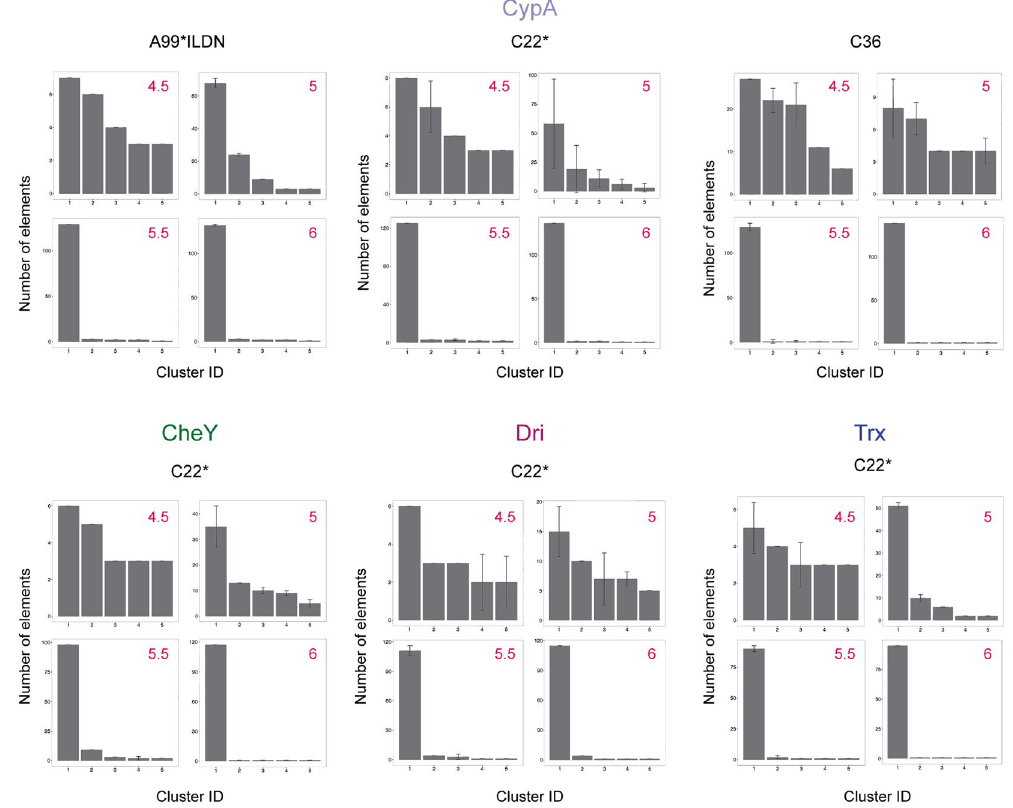
Figure 4. Connected component distribution at different distance cutoffs used for the PSN-MD analyses. We evaluated changes in the population of the connected components (i.e. clusters) as a function of different distance cutoffs in the PSN derived from the entire MD trajectory (histogram values) and the associated standard deviations (error bars) calculated from the average PSNs obtained from the Jackknife resampled trajectories (see Materials and Methods). We reported in the plot only the first five most populated clusters for sake of clarity. We observed that at distance cutoffs higher than 5 Å, most of the nodes of the PSN were located in the same cluster (cluster ID 1). This result suggests that 5 Å is an optimal distance cutoff to predict residue contacts in PSN.